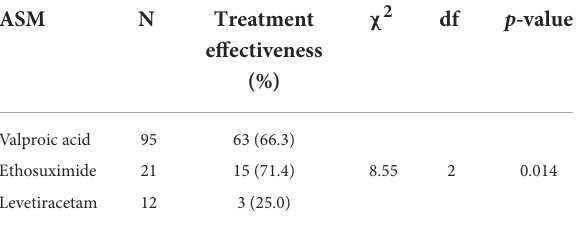
TABLE 2 Effectiveness of first-line ASM